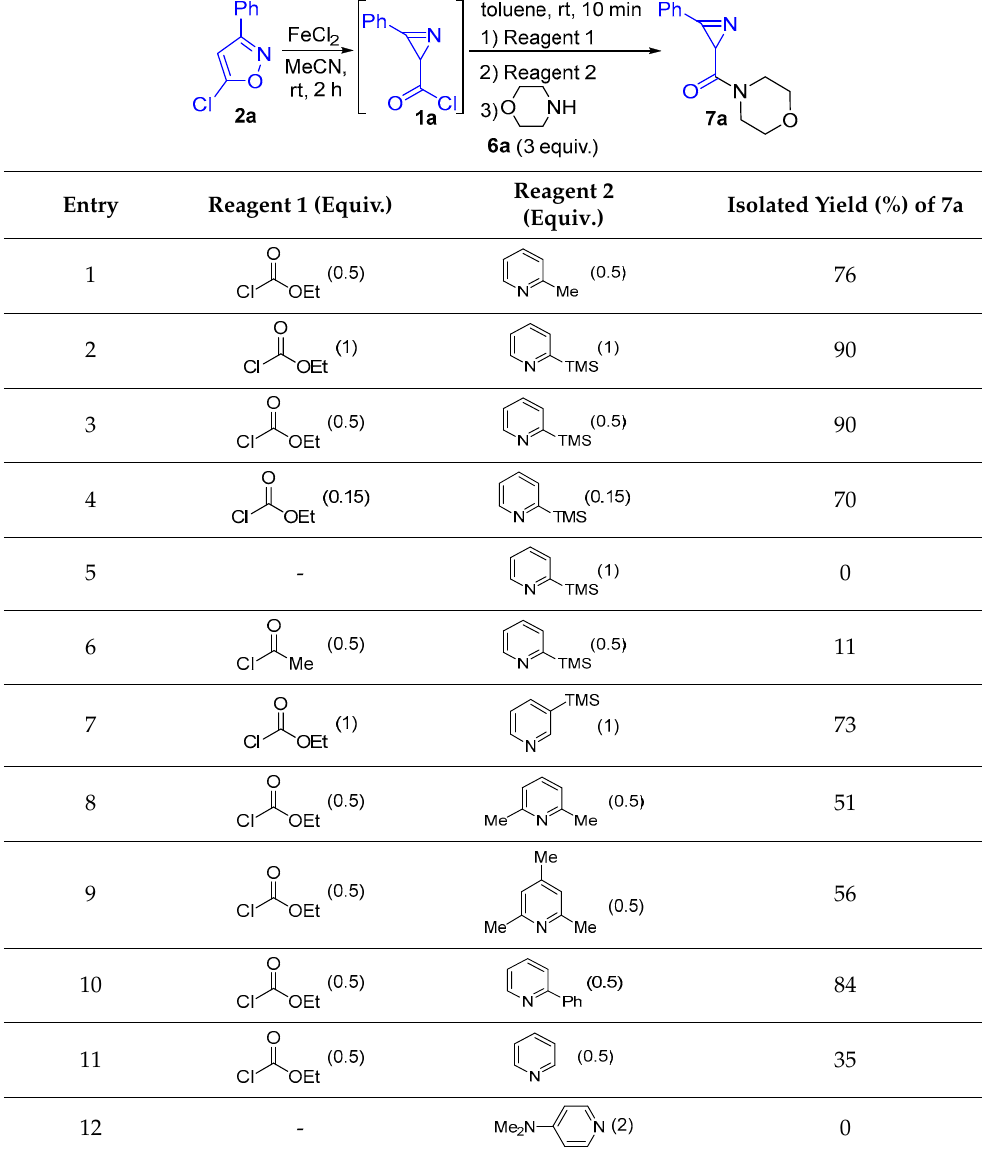
Then, experiments were carried out with various amines, 6a – h, under optimal con ‐ 151